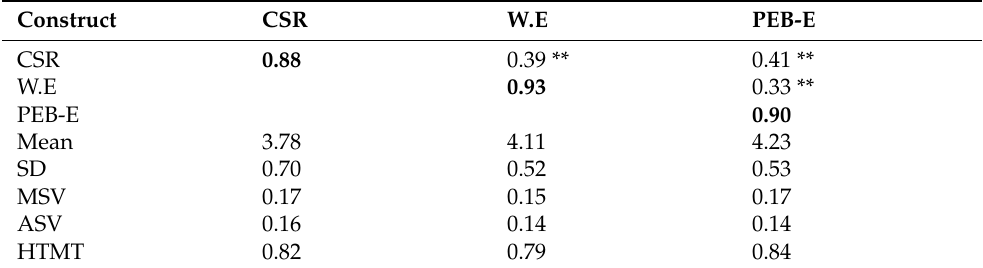
Table 4. Correlation, discriminant validity and model fit